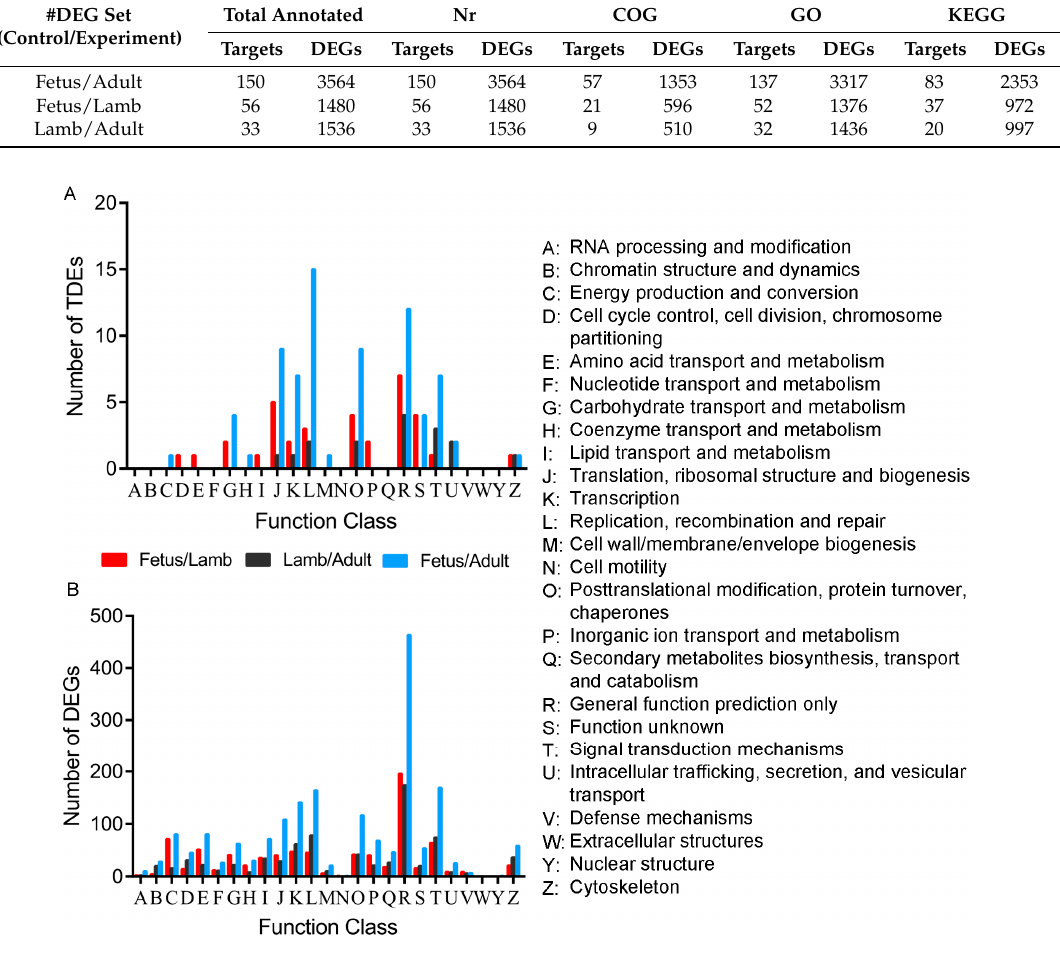
Figure 7. COG classification of all the target genes of the differentially expressed lncRNAs and DEGs during sheep muscle growth. ( A ) COG analysis for all the target genes of the differentially expressed lncRNAs. ( B ) COG analysis for all the DEGs.